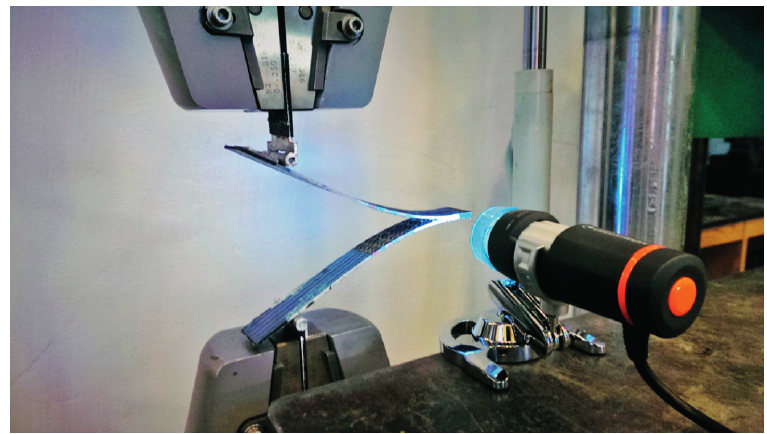
Figure 5. The DCB test setup with an optical microscope used to monitor and record the delamination growth.